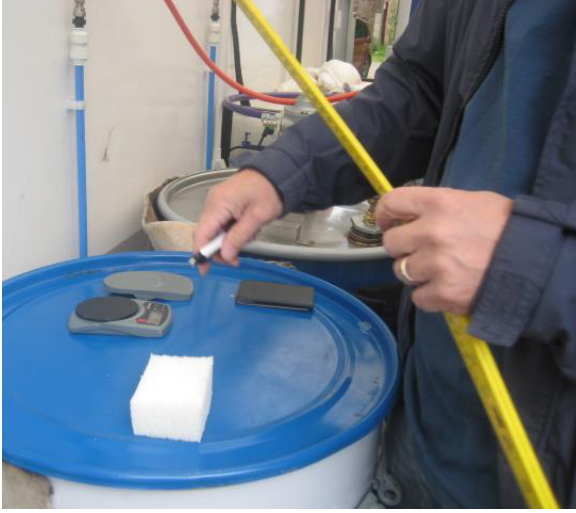
Figure 10. Sample of debris removed from the wall during this phase of the trial despite the cleaning prior to the start The equipment was changed over from the spray foam material to the pour foam material, and samples taken to prove the correct rate of expansion.